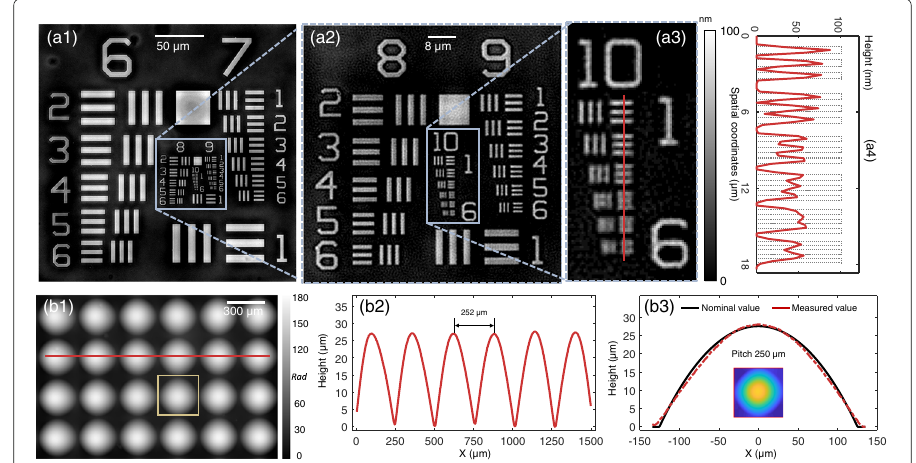
Fig. 16 QPI experiment results on standard phase resolution targets QPT TM and microlens array. (a1)-(a3) Reconstructed quantitative phase and its sub-region images. (a4) The quantitative profile along the red line in (a3). (b1) Reconstructed quantitative phase of the microlens array. (b2) The quantitative profile along the red line in (b1). (b3) Comparison of quantitative profile of reconstructed phase and nominal